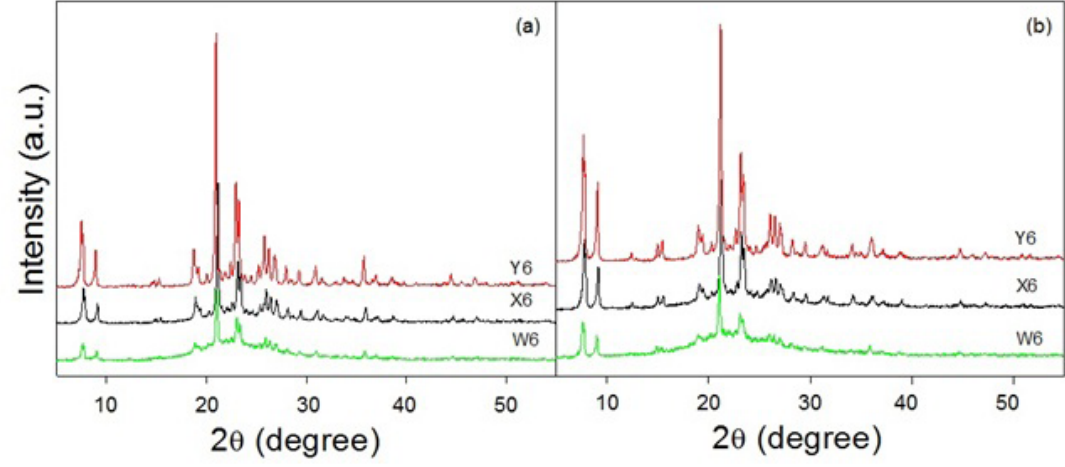
Fig. 1. X-ray diffractogram of X6, Y6 and W6 ZSM-12 samples: (a) non-calcined and (b) calcined samples.